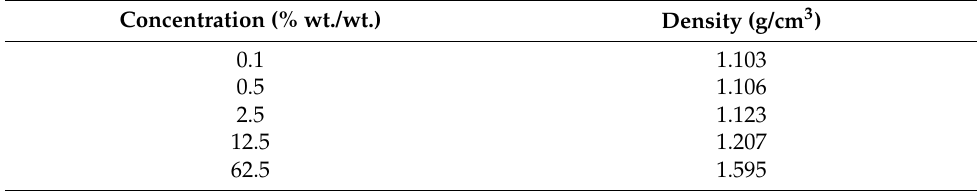
Figure 6. Membrane thicknesses obtained for membranes fabricated with different concentrations of PDMS-GOS:Eu powder. Results are presented for three different spin-coating velocities (( a ) 1000 rpm, ( b ) 2000 rpm and ( c ) 4000 rpm) and for the indicated spinning times ( t vc ). Table 2. Concentrations and densities of the PDMS-GOS:Eu composites.